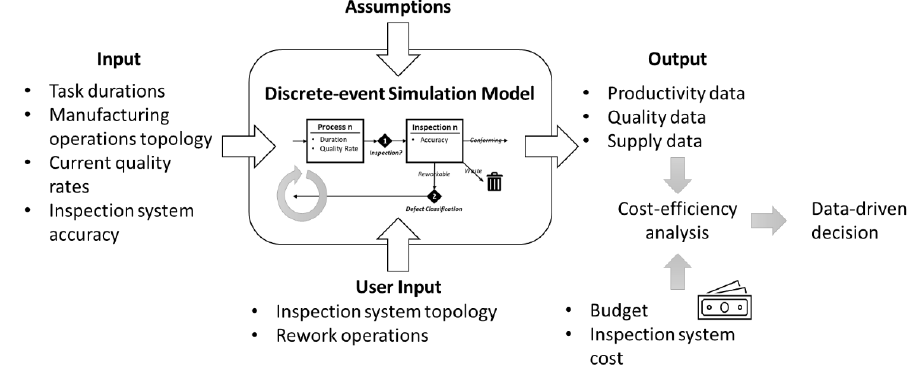
Figure 1. Proposed model overview with necessary inputs and expected outputs.